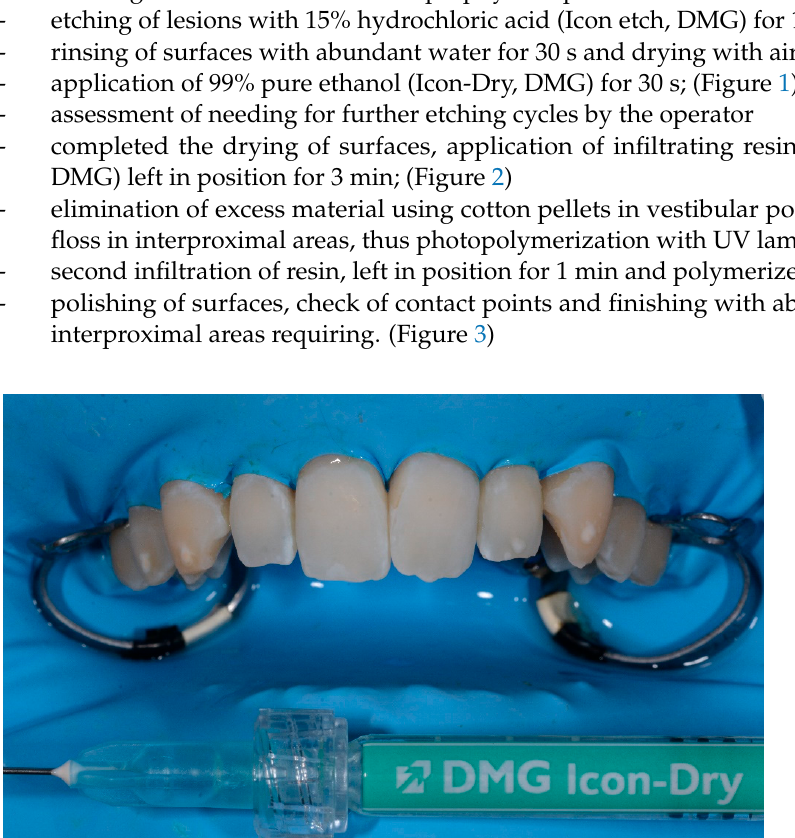
Figure 1. Application of ethanol .